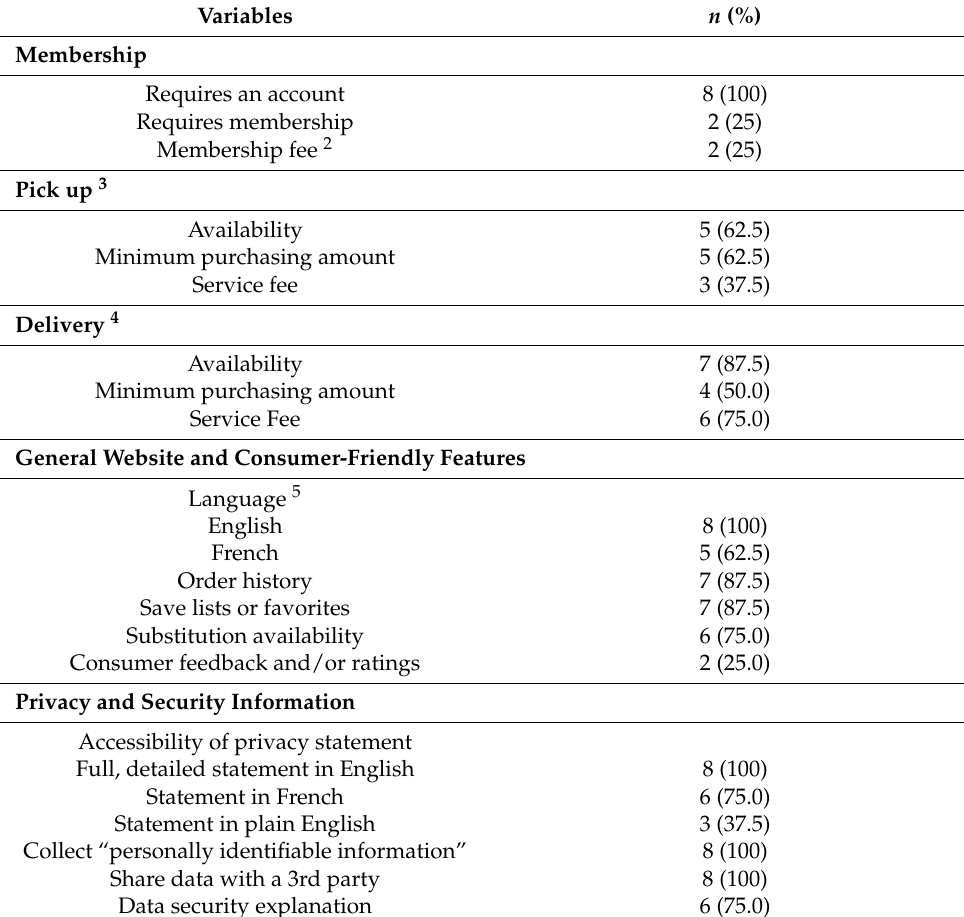
Table 1. Summary Characteristics of the eight Canadian grocery websites 1